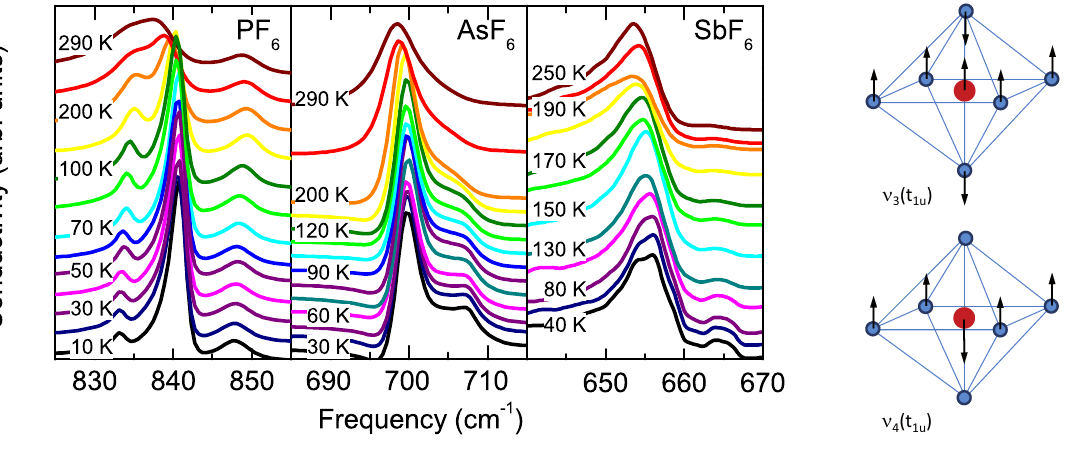
PF , (TMTTF) AsF and (TMTTF) SbF in 2 6 2 6 2 6 ( t ) obtained with light polarized perpendicular 4 1 u , the modes split by about 7.5 cm − 1 due CO ions (where M = P, As, and Sb is shown 6 ( t ) is around 500 cm − 1 3 1 u ( t ) mode is seen around 650 to 840 cm − 1 . 4 1 u